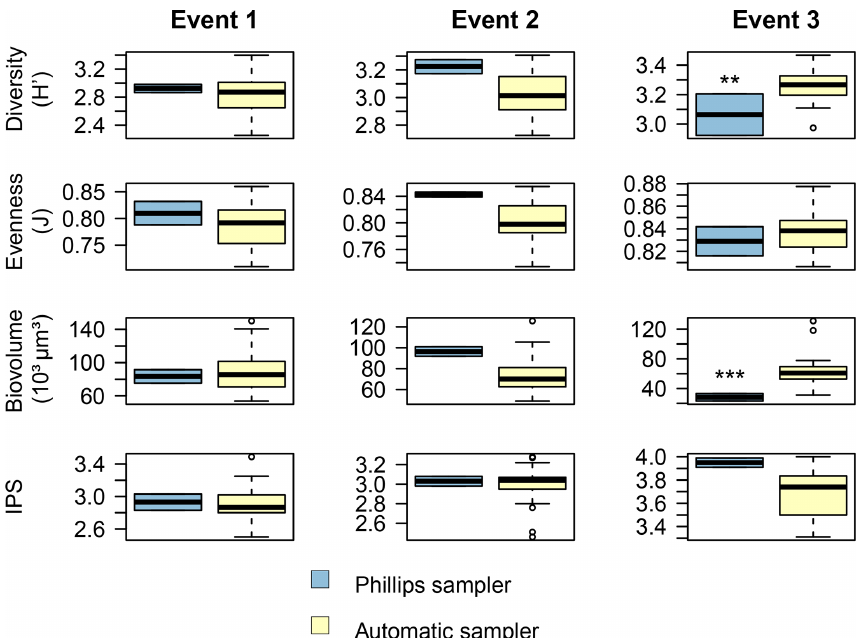
Figure 7. Comparison of the diatom community data between the two sampling methods for each event. The Shannon–Wiener index ( H (cid:48) ) generally ranges between 1.5 (low diversity) and 3.5 (high diversity). Pielou’s evenness ( J ) ranges between 0 (low evenness) and 1 (high evenness). The specific pollution sensitivity index (IPS) ranges between 1 (poor water quality) and 5 (high quality). Calculations were based on relative abundance data. ∗∗ P < 0 . 01, ∗∗∗ P < 0 .